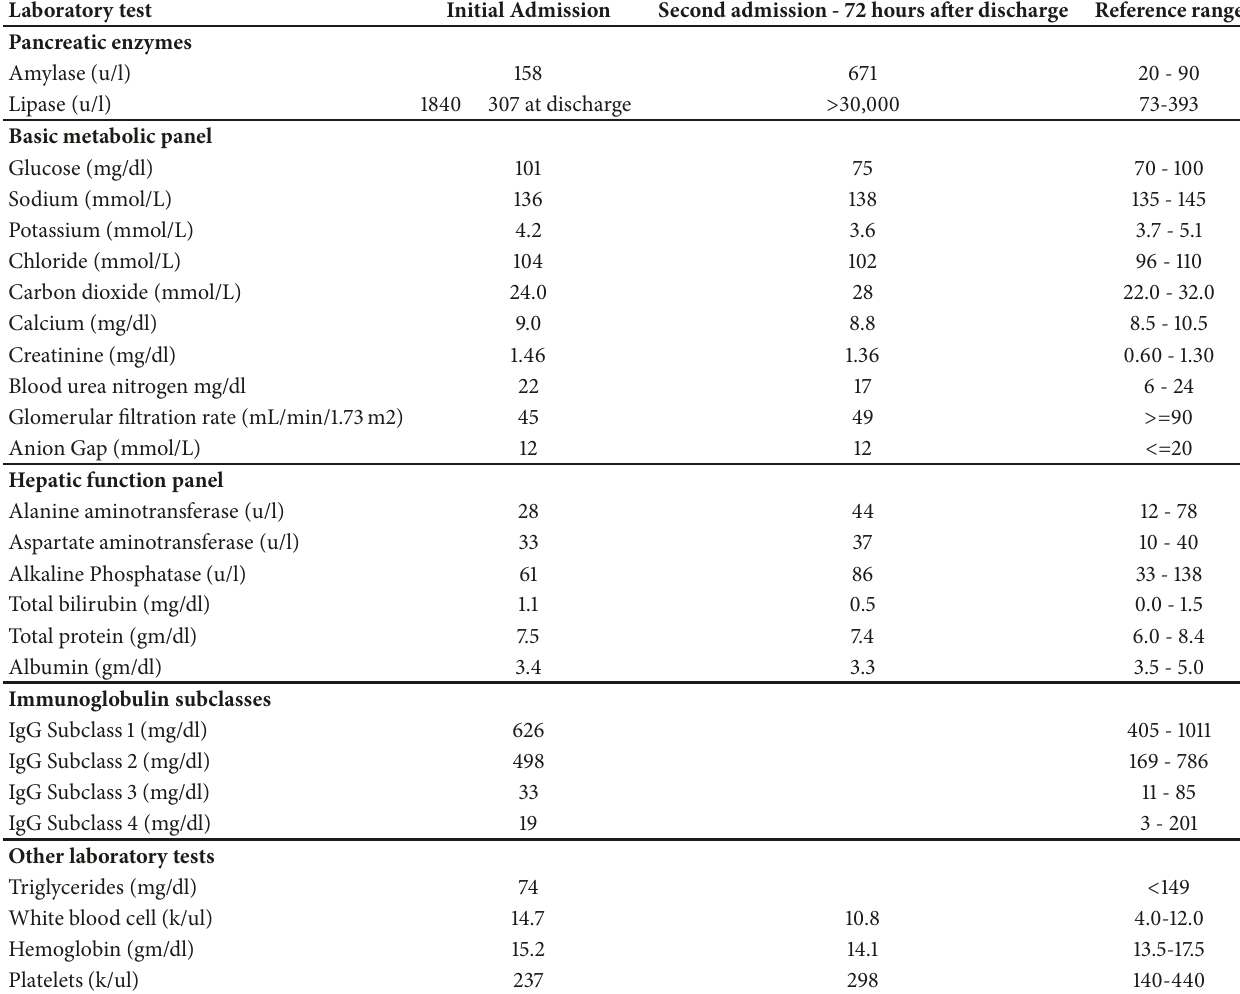
Table 1: Laboratory markers: initial admission; second admission after drug rechallenge.